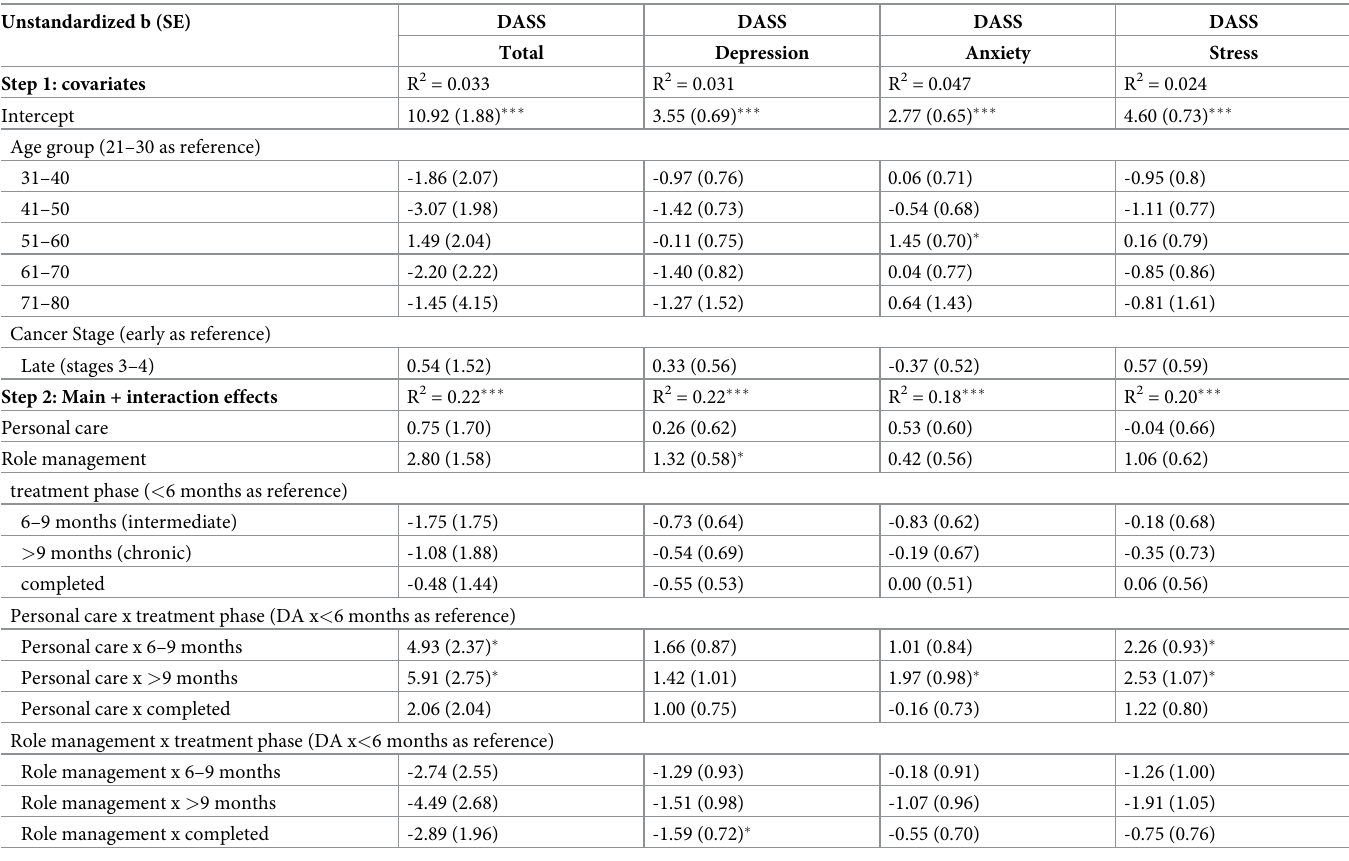
Table 2. Unstandardized regression coefficients of predictors of depressive